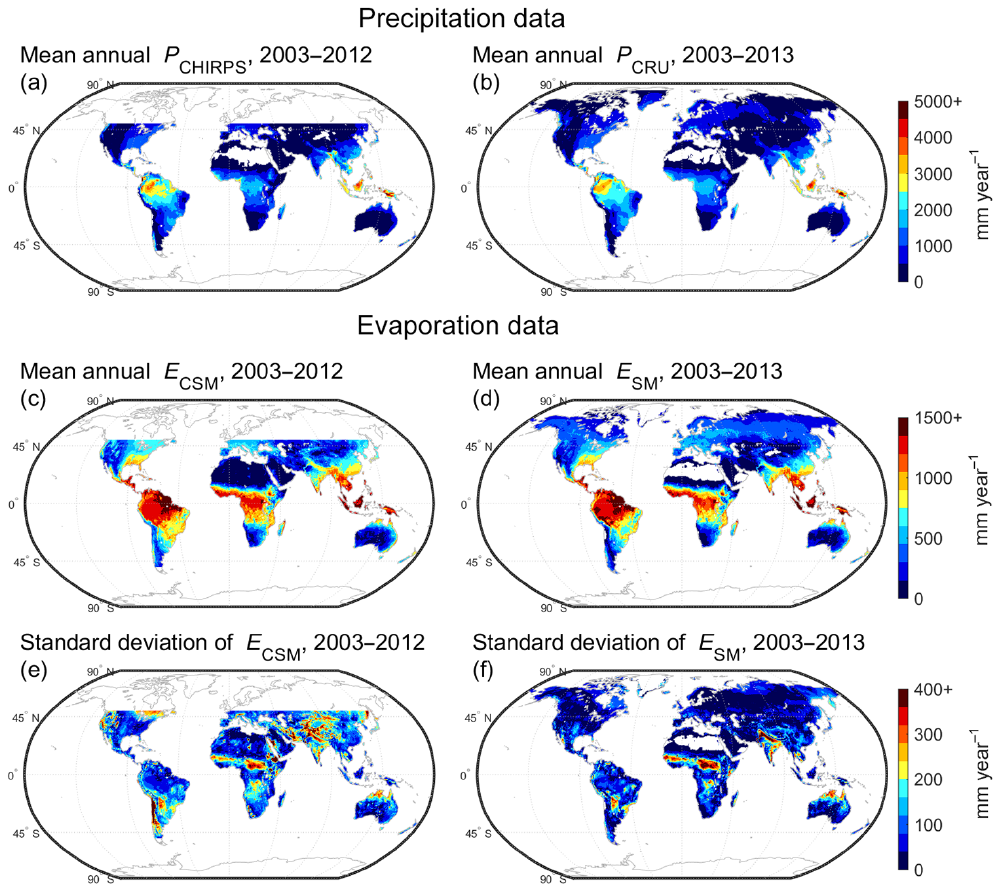
Figure 2. The mean annual precipitation of (a) CHIRPS ( P CHIRPS ) for the years 2003–2012 (50 ◦ N–50 ◦ S), and (b) CRU ( P CRU ) for the years 2003–2013 (80 ◦ N–56 ◦ S). The mean annual ensemble evaporation of (c) CMRSET, SSEBop, and MOD16 ( E CSM ) for the years 2003–2012 (50 ◦ N–50 ◦ S), and (e) SSEBop and MOD16 ( E SM ) for the years 2003–2013 (80 ◦ N–56 ◦ S). Standard deviation of ensemble evaporation of (e) E CSM , and (f) E SM . Values below 0.5% of the maximum are displayed as